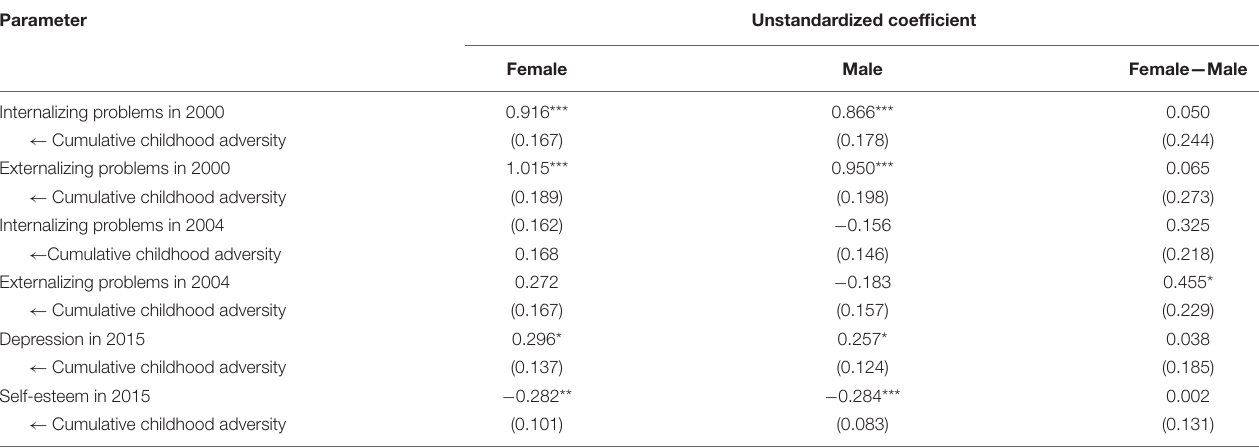
FIGURE 5 | Illustration of educational attainment as a mediator of cumulative childhood adversity and mental health in adulthood. Age and gender are not shown in this figure for simplicity. Numbers on arrows are unstandardized regression coefficients. ∗ < 0.05, ∗∗ < 0.01, ∗∗∗ < 0.001. TABLE 6 | Gender differences in the associations between cumulative childhood adversity and mental